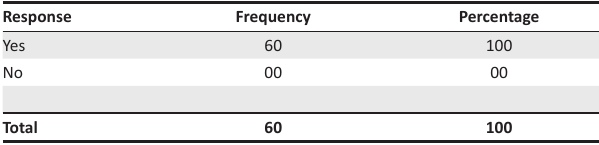
TABLE 5: Participants response to the reward management at Ghana Commercial Bank which includes commission-based pay. Response